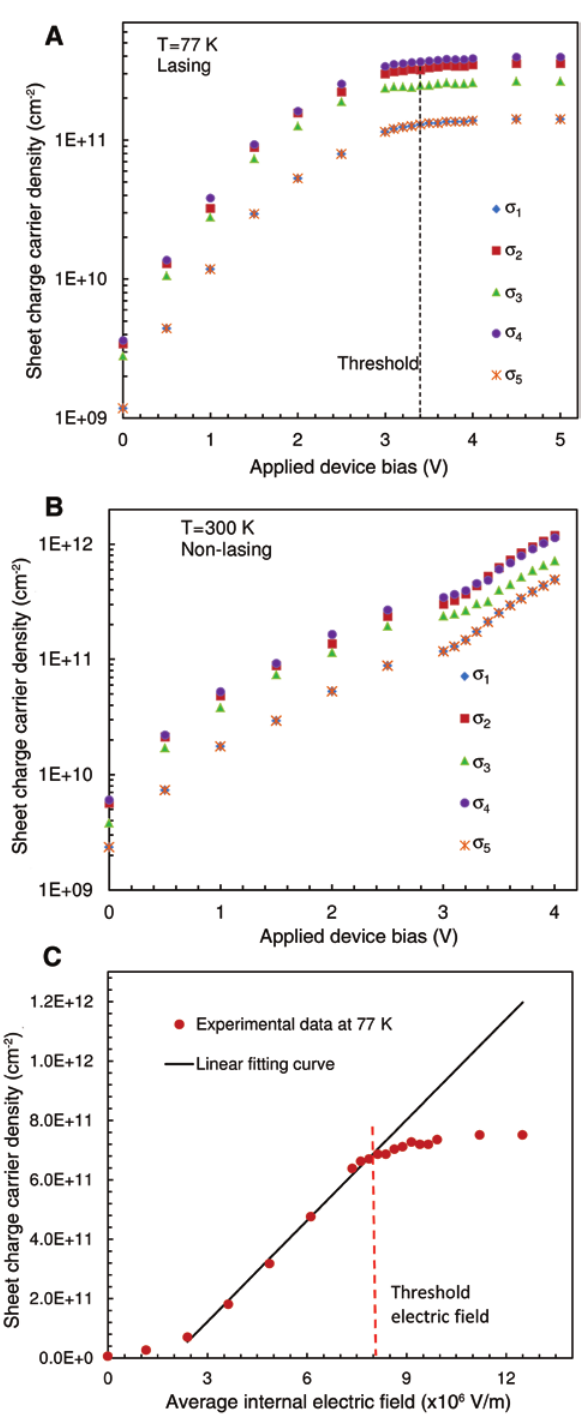
Figure 23: (A) The experimental sheet charge carrier densities at different device biases at 77 K. The threshold voltage at 77 K is 3.4 V. (B) The experimental sheet charge carrier densities at different device biases at room temperature. The device does not lase at room temperature. (C) The experimental total electron + σ density ( σ ) as a function of the internal average electric field. 2 4 A linear fitting curve (solid line) based on Eq. (3) is plotted for